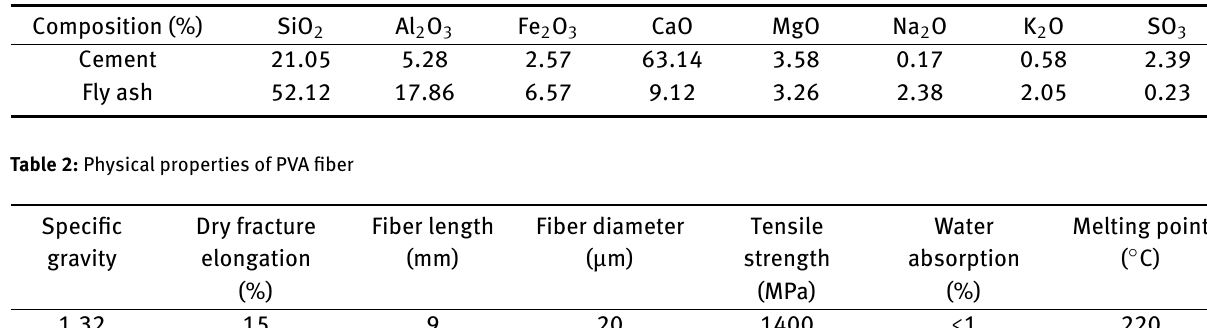
Table 1: Composition of cement and fly ash Composition (%) SiO 2 Al 2 O 3 Fe 2 O 3 CaO MgO Na 2 O K 2 O SO 3 Cement 21.05 Fly ash